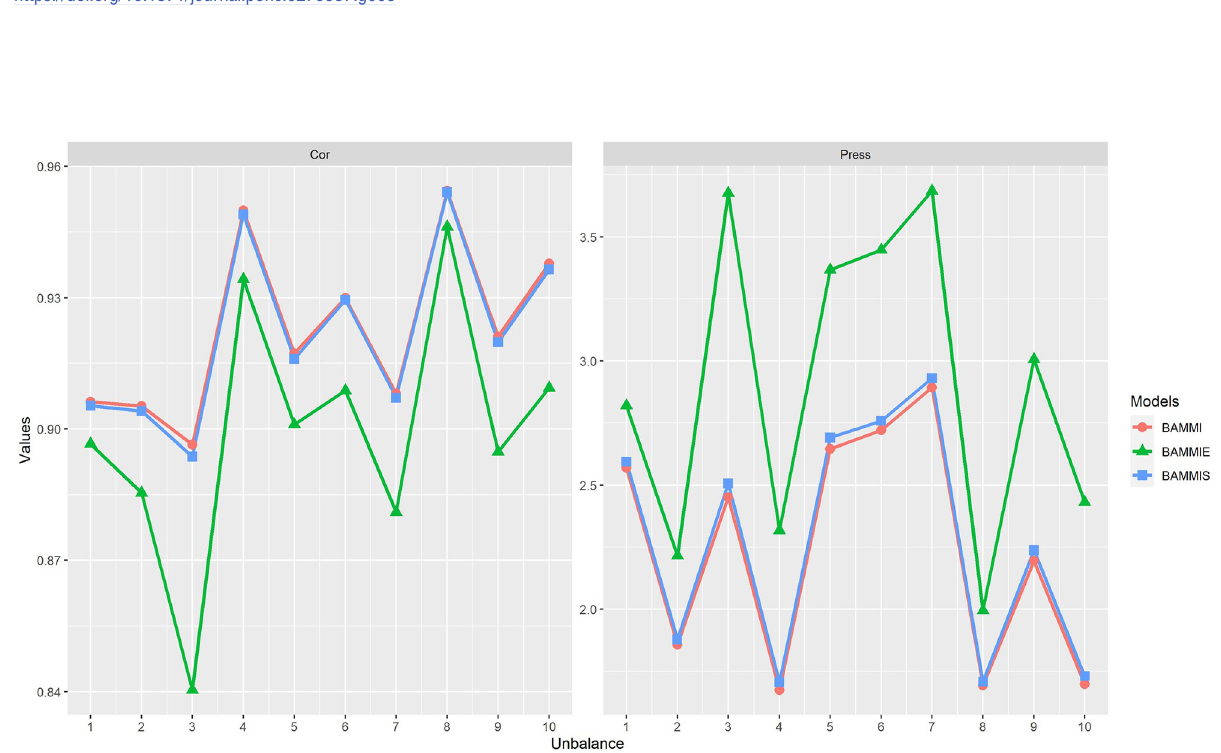
Fig 9. Ockham’s plot for the mean evaluation of the predictive capacity of the models based on the criteria of correlation between the observed and estimated values and the PRESS (RJMCMC algorithm).